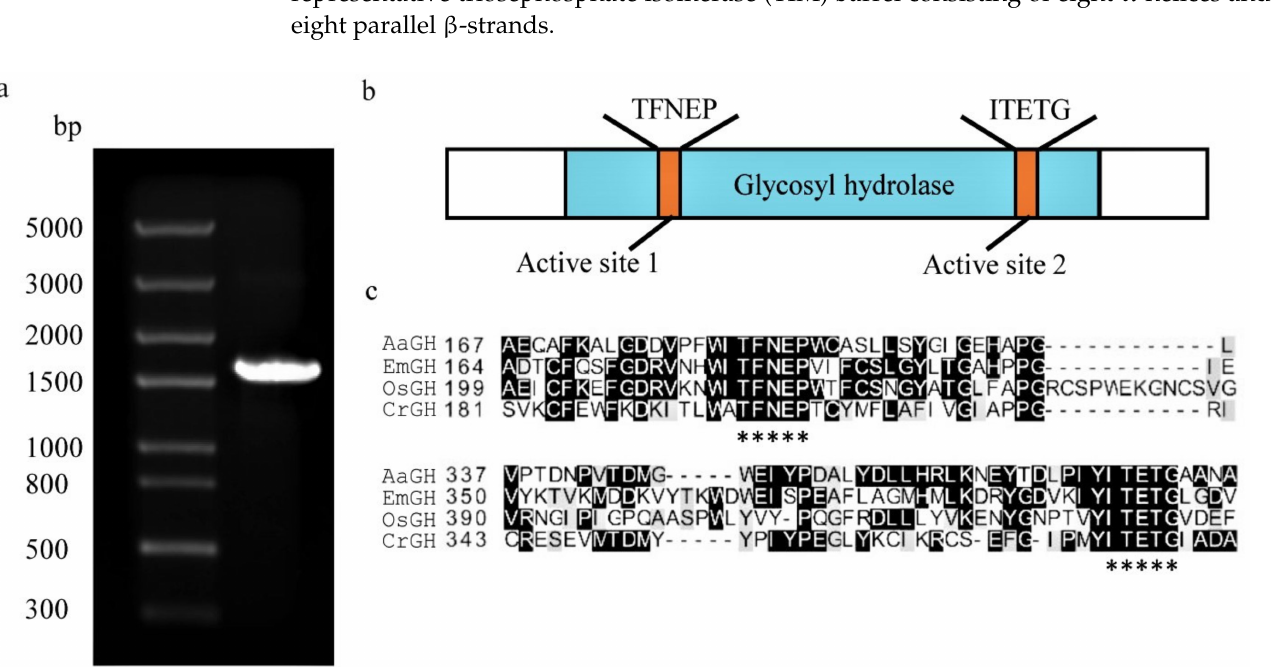
Figure 1. Cloning of the galactosyl hydrolase gene from Chlamydomonas reinhardtii and bioinformatics analysis. ( a ). The PCR amplification of CrGH (~1527 bp). ( b ). Functional domains of the putative CrGH, which consists of active sites (turquoise boxes) and glycosyl hydrolase domain (orange box). ( c ). Multiple protein sequence alignment of glycosyl hydrolases of Alicyclobacillus acidiphilus (AaGH, accession number: WP_067621817.1), Exiguobacterium marinum (EmGH, accession number: WP_026824377.1), Oryza sativa (OsGH, accession number: 3PTQ_B), and C. reinhardtii (CrGH, GenBank: Cre03.g171050.t1.1). The sites of the active site peptide motifs (TFNEP and ITETG) are indicated